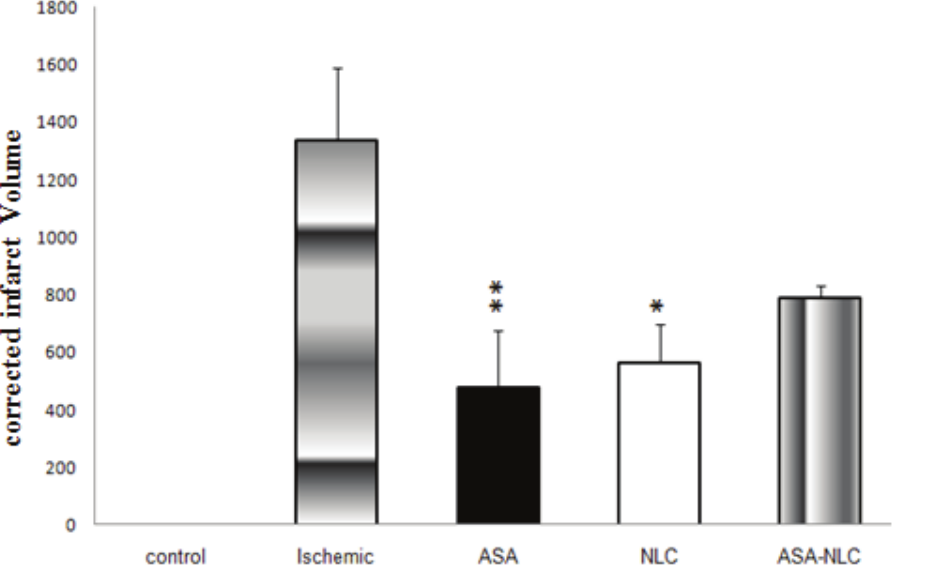
Figure 6: Corrected infarct volume decreased in all treatment groups compared with the Ischemic group. A statistically significant decrease was detected in ASA and NLC groups compared with the Ischemic group. *, p ≤ 0.05; **, p ≤ 0.01.